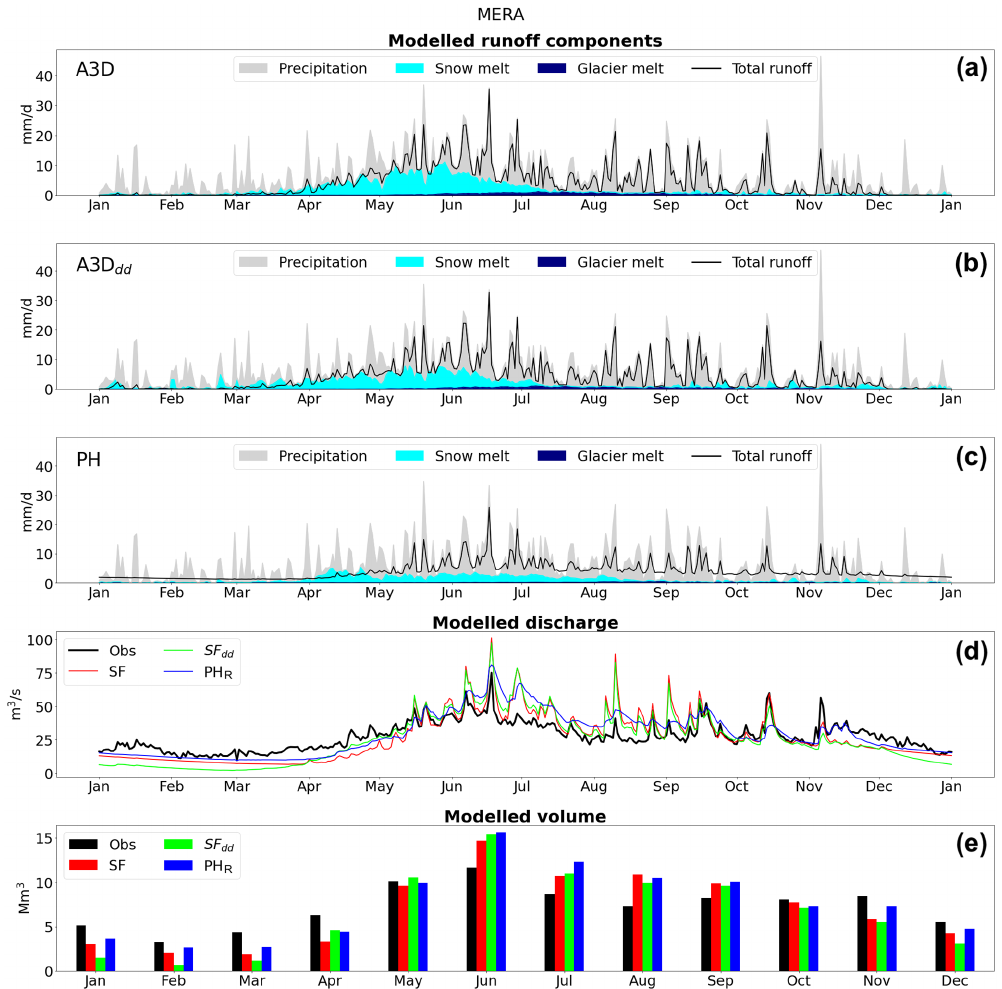
Figure 6. Panels (a–c) : modelled runoff components over the Mera catchment reproduced with the full solver of Alpine3D (A3D), the degree- day melting scheme of Alpine3D (A3D DD ) and Poli-Hydro (PH), respectively. Panels (d, e) : discharge and monthly volumes modelled by StreamFlow using output from the full solver of Alpine3D (SF) or its degree-day scheme (SF DD ) and modelled by Poli-Hydro (PH R ) compared with measurements. Results for the validation years 2015–2018, averaged by day of the year and by